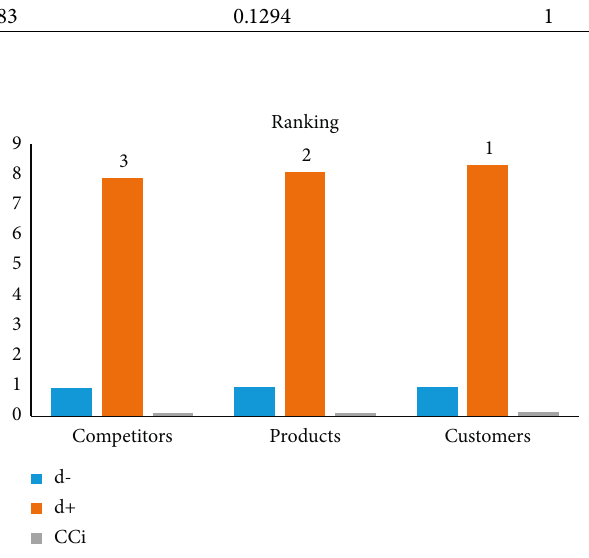
Figure 3: Weighted normalized fuzzy decision matrix